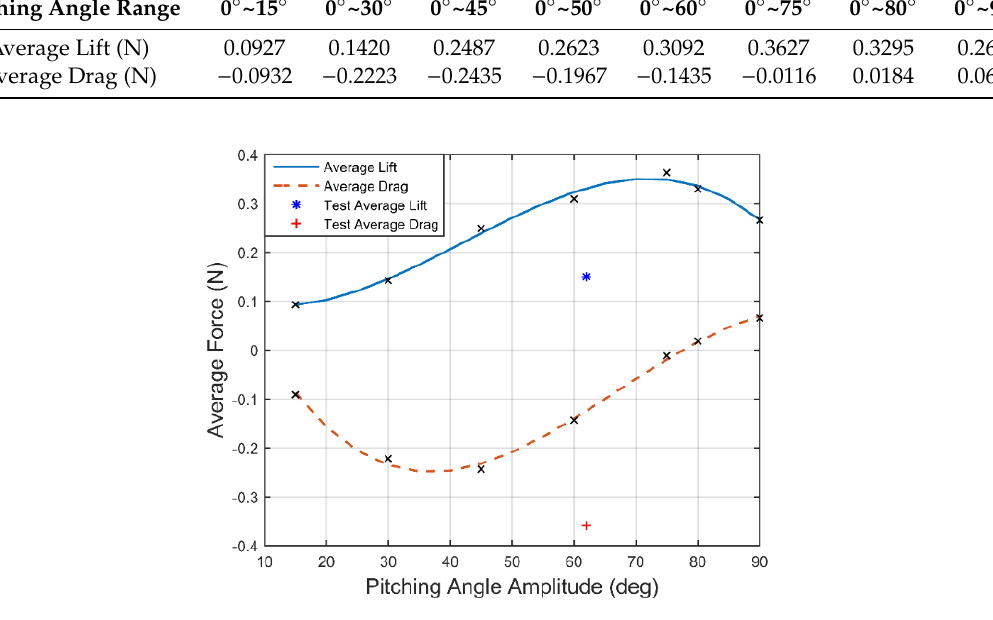
Figure 18. The lift forces of flapping wing with pitching angle case 0°~45°, 0°~75° and 0°~90° (down- stroke: 𝑡̂ = 0~0.25; up-stroke: 𝑡̂ = 0.25~0.75; down-stroke: 𝑡̂ = 0.75~1).